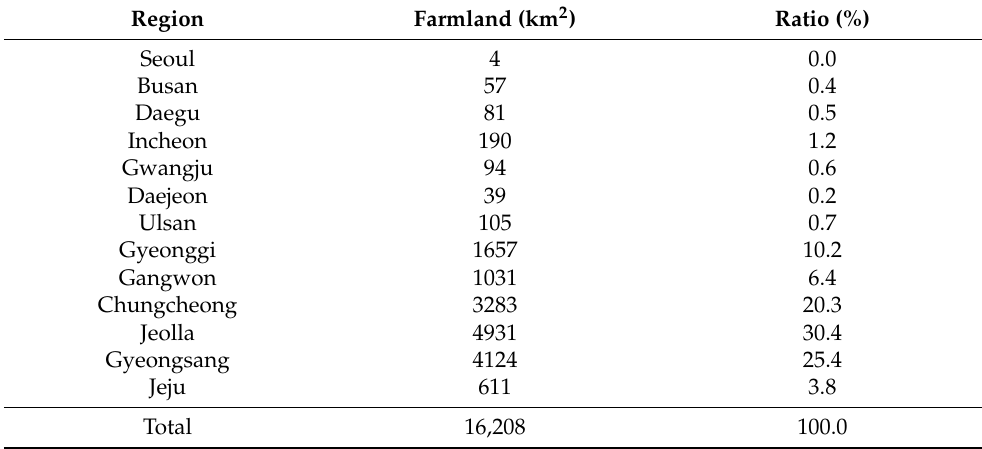
Table 3. Area and area ratio of farmland by region